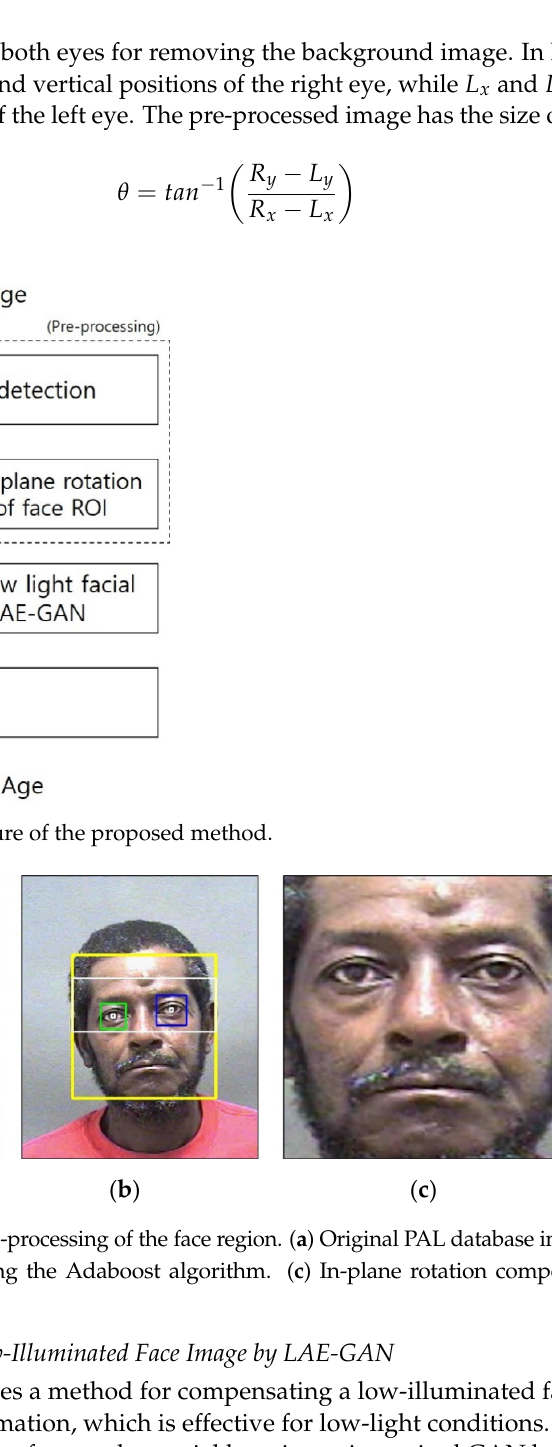
Figure 2. Procedure of pre-processing of the face region. ( a ) Original PAL database image. ( b ) De- tected face and eye regions using the Adaboost algorithm. ( c ) In-plane rotation compensation and face ROI redefinition.